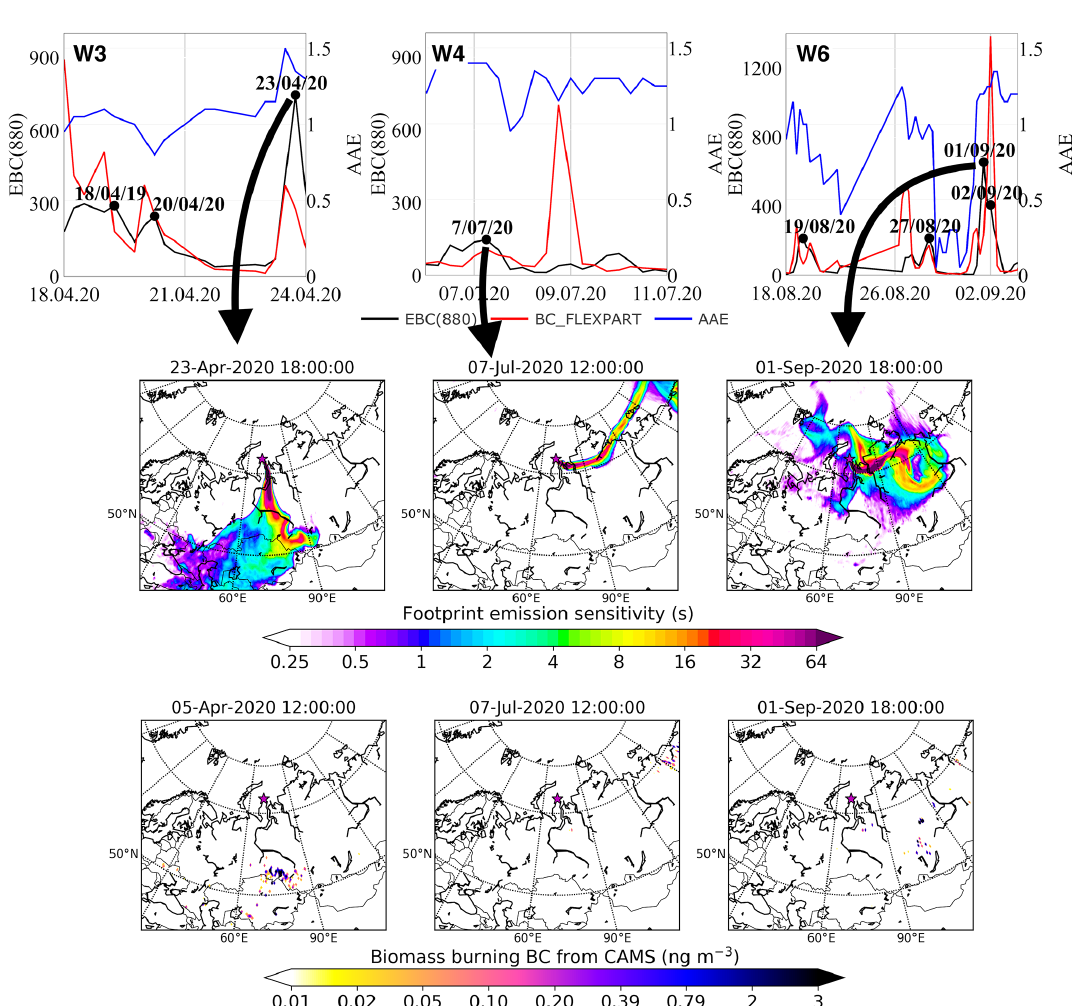
Figure 9. Examples of pollution episodes W3, W4 and W6 in the warm period (see Fig. 5b), during which BB contribution prevails. The figure has been arranged similar to Fig. 7 (time series of measured EBC, modeled BC and AAE, footprint emissions sensitivities and BB contribution to surface